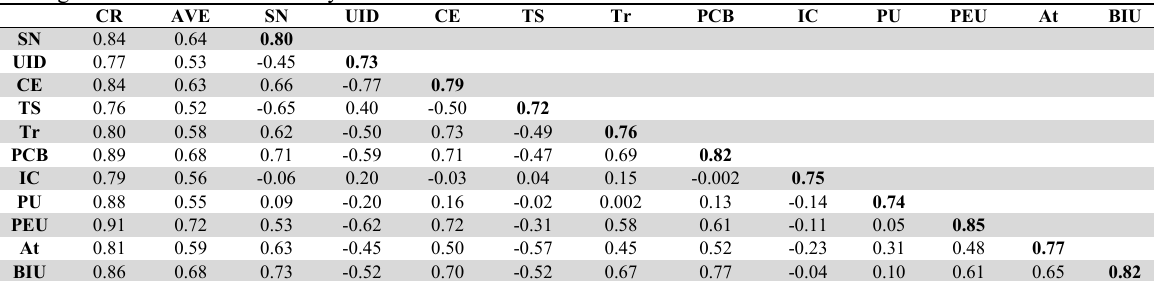
Convergent and discriminant validity